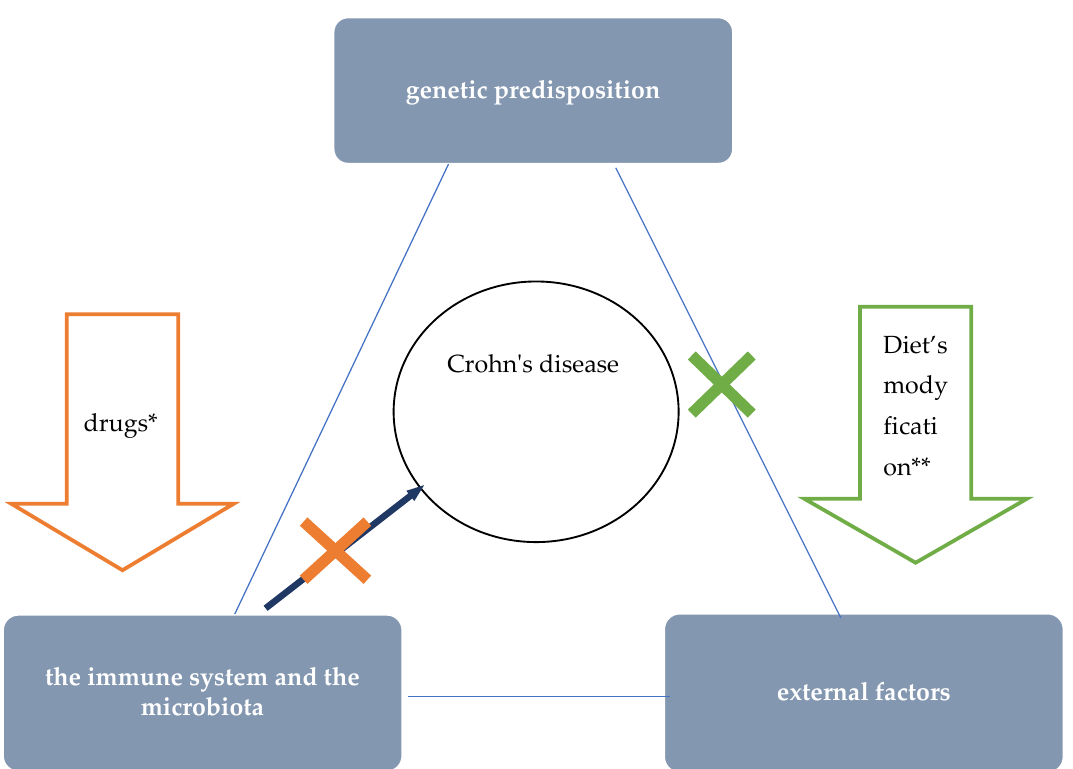
Figure 1. The role of nutritional therapy in the treatment of Crohn's disease. * steroids, immunosuppressants and biologics ** such as Exclusive Enteral Nutrition (EEN)